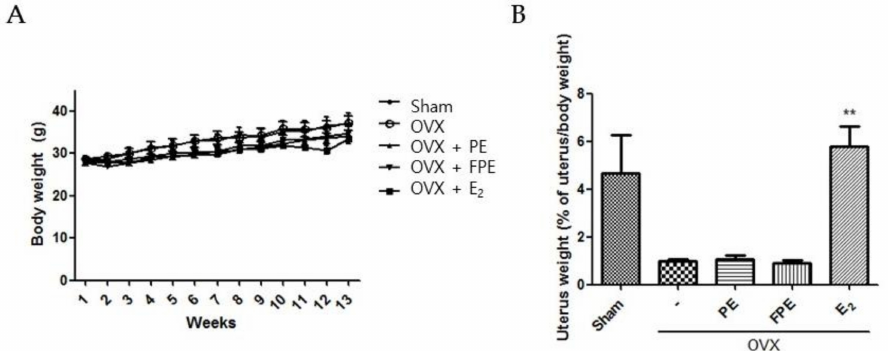
Figure 6. Effects of FPE on changes of body weight and uterus weight in OVX-induced mice. ( A ) Body weight was measured once a week; ( B ) at the end of the experiment, the uterus was removed and weighed. PE: Pueraria lobata extract; FPE: fermented Pueraria lobata extract. ** p < 0.01 compared to OVX induced control.